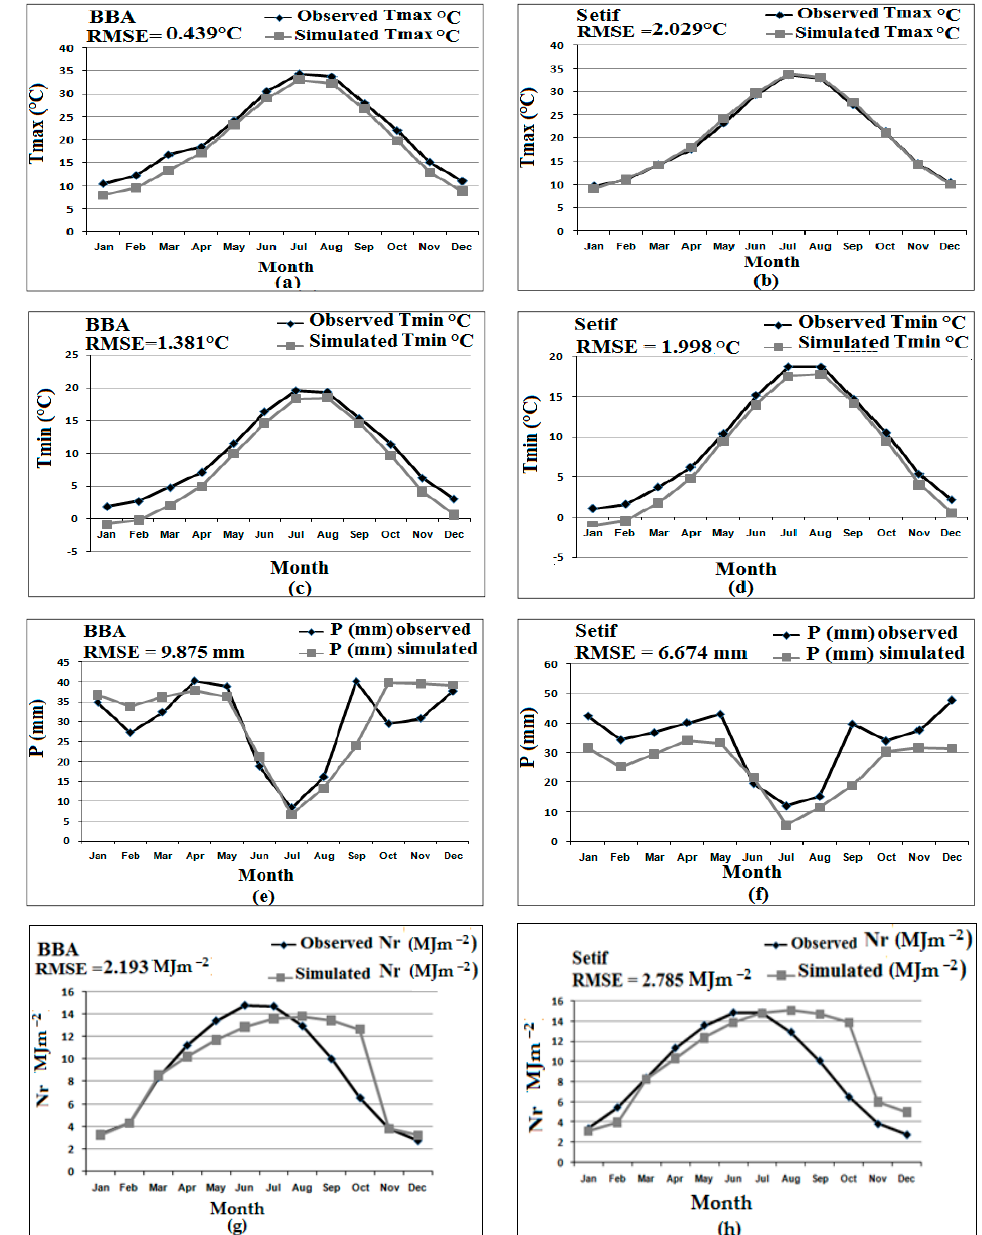
Figure 2. Comparison of the degree of agreement between the observed and simulated Tmin, Tmax, P, and Nr monthly means at Setif and BBA stations during the BP.